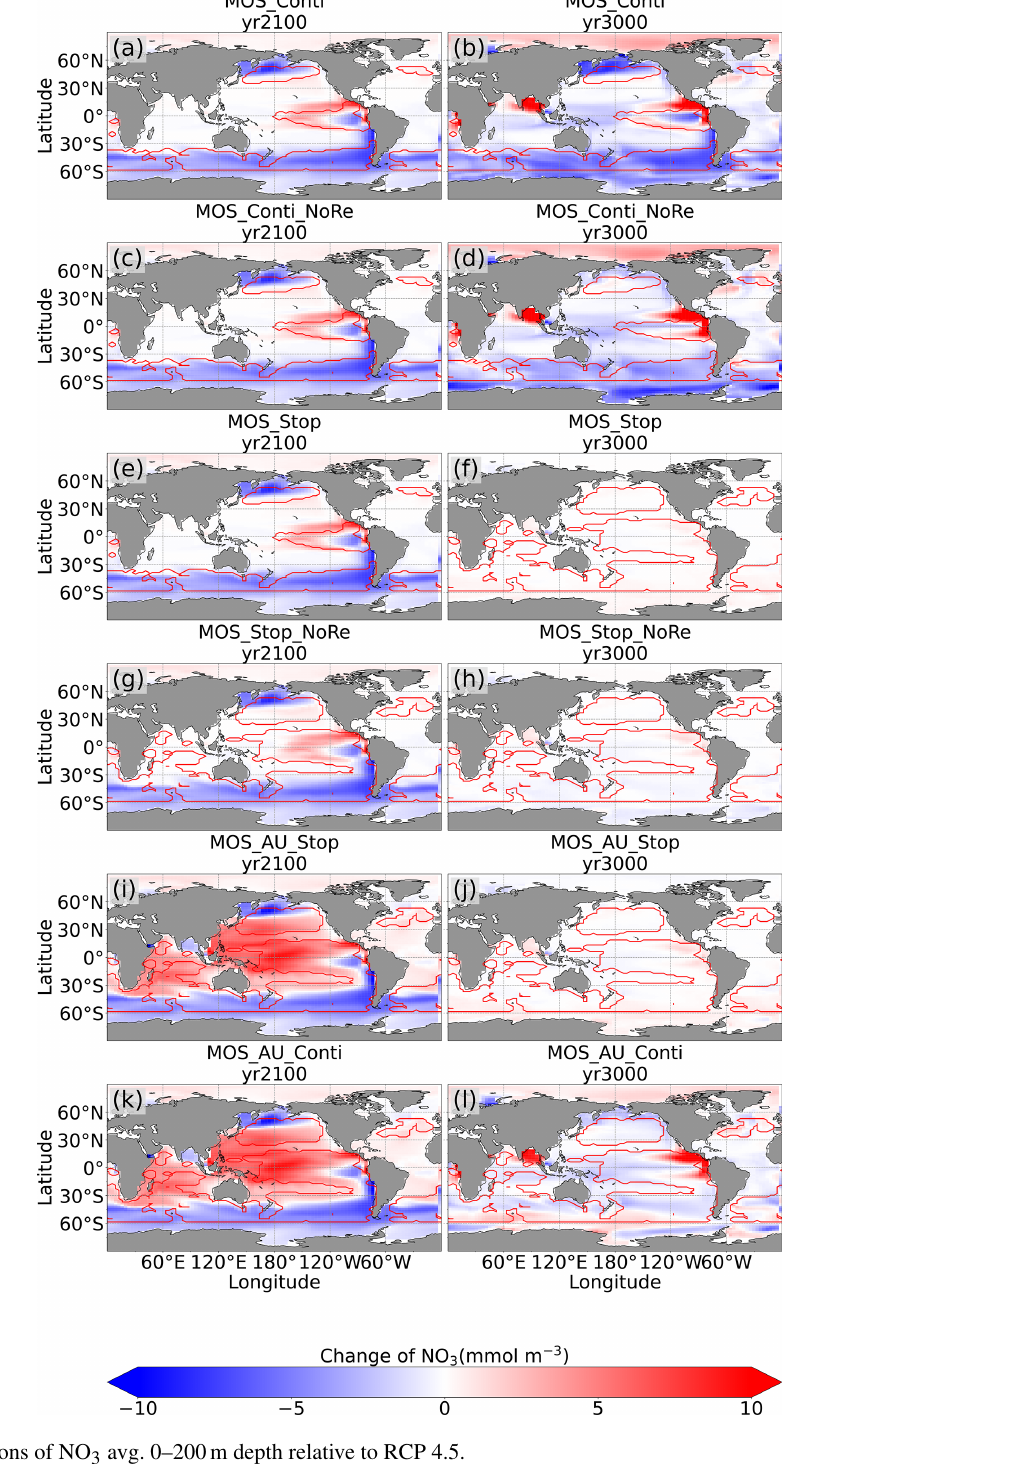
Figure B9. Redistributions of NO 3 avg. 0–200m depth relative to RCP 4.5.